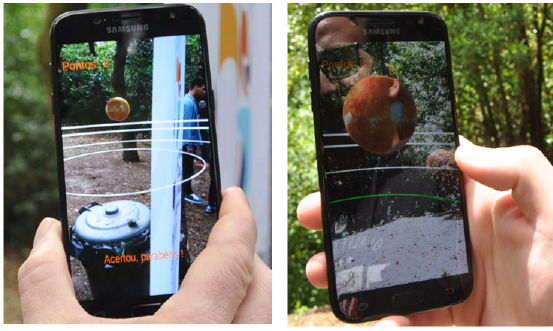
Figure 5. Hunting orbits and planets.